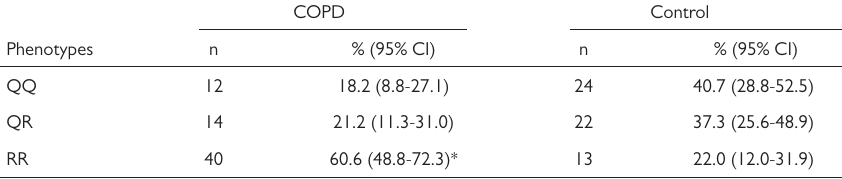
Table 2. PON1 phenotype distribution in patient and control subjects COPD